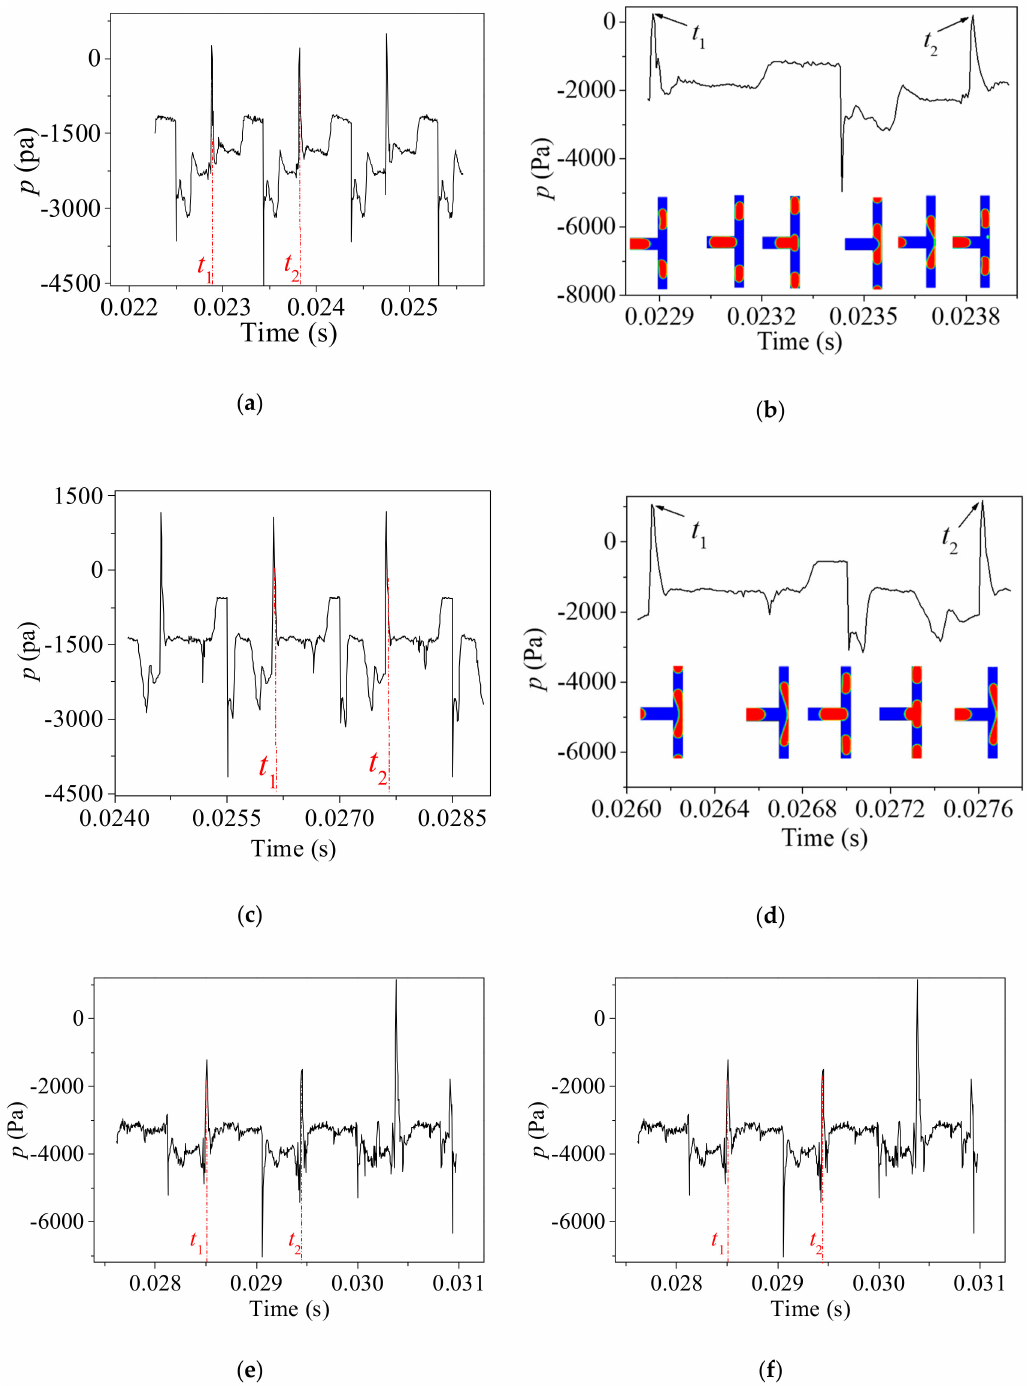
Figure 5. Pressure variation at the center of the first bifurcation. ( a , b ): Ca 0 = 0.0111; ( c , d ): Ca 0 = 0.00694; ( e , f ): Ca 0 =